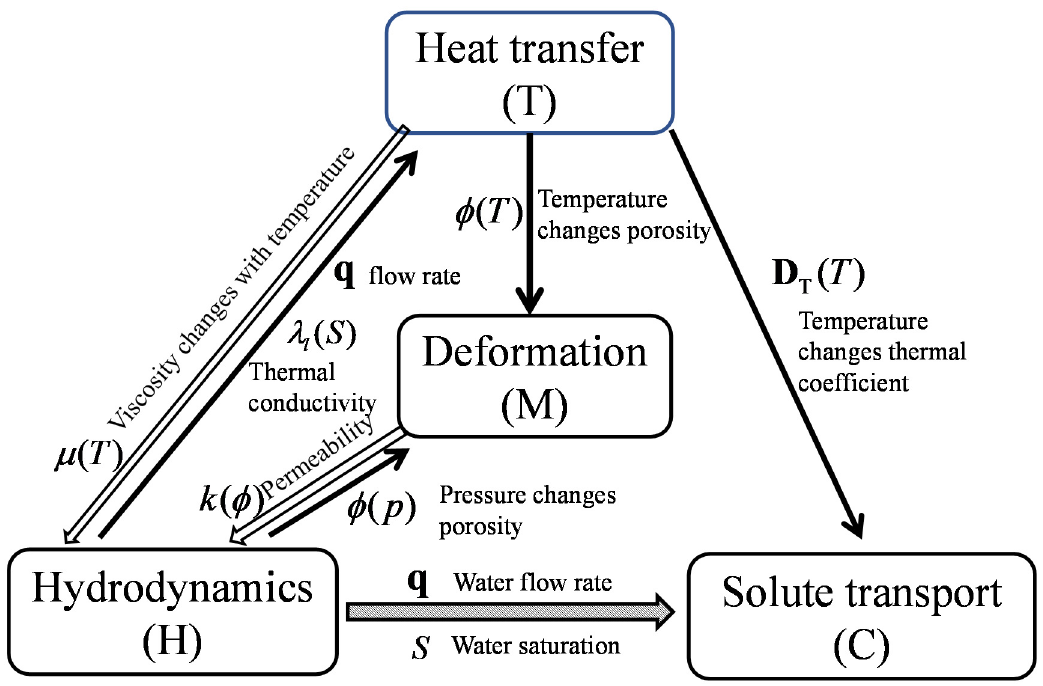
Figure 1. Coupling in heat-flow deformation solute transport model.